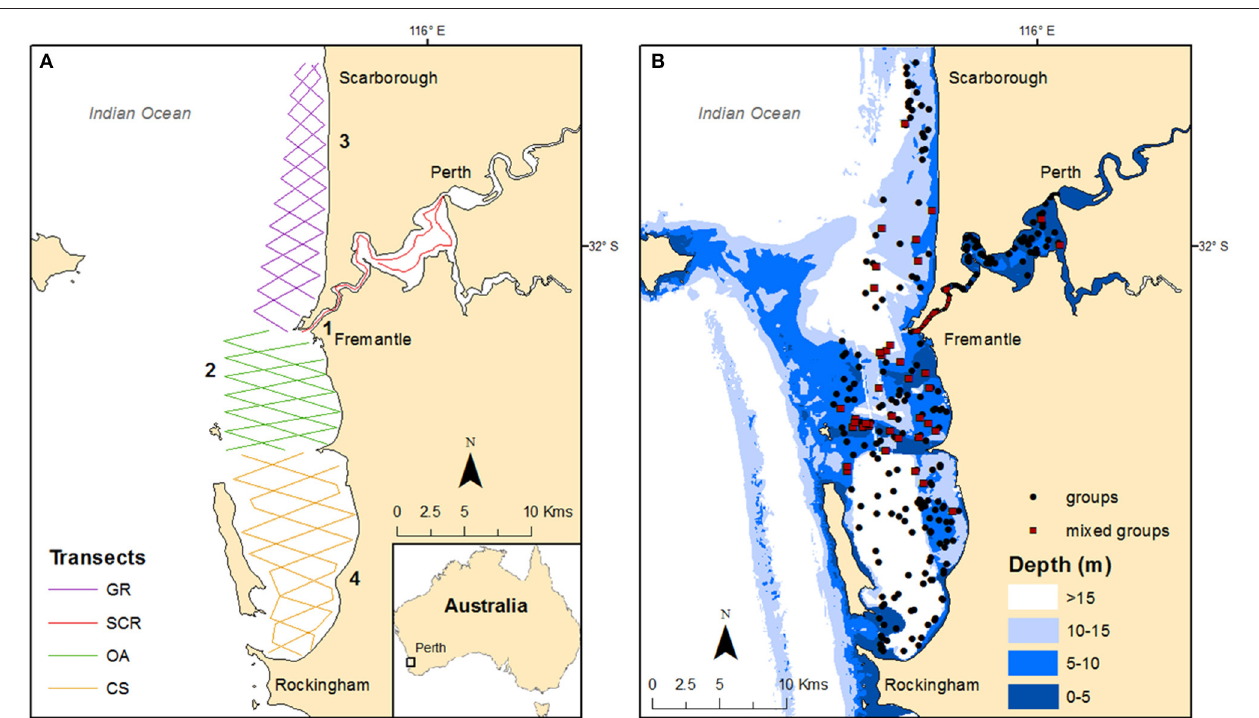
FIGURE 1 | Maps of the study area showing: (A) the transect routes per geographic regions (GR, Gage Roads; SCR, Swan Canning Riverpark; OA, Owen Anchorage; CS, Cockburn Sound) with locations of past, current, and proposed developments (1- pile driving; 2- dredging; 3- desalination; 4- outer harbor); and (B) the bathymetry (in meters) with the locations of the groups sighted during the systematic surveys conducted from 2011 to 2015, including mixed groups (i.e., mix of individuals from different